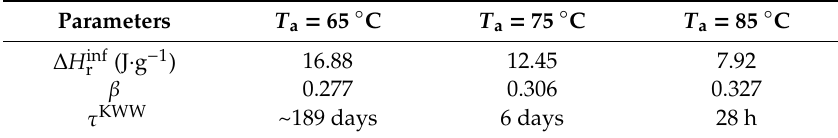
Table 1. Parameters describing the kinetics of the physical ageing process of indapamide at ageing temperatures ( T a ) 65, 75 and 85 ◦ C determined by the experimental data fitted to the Kohlrausch-Williams-Watts (KWW) equation. ∆ H inf r is the equilibrium enthalpy relaxation, τ KWW is the relaxation time and β is the coe ffi cient describing the distribution of the relaxation time.